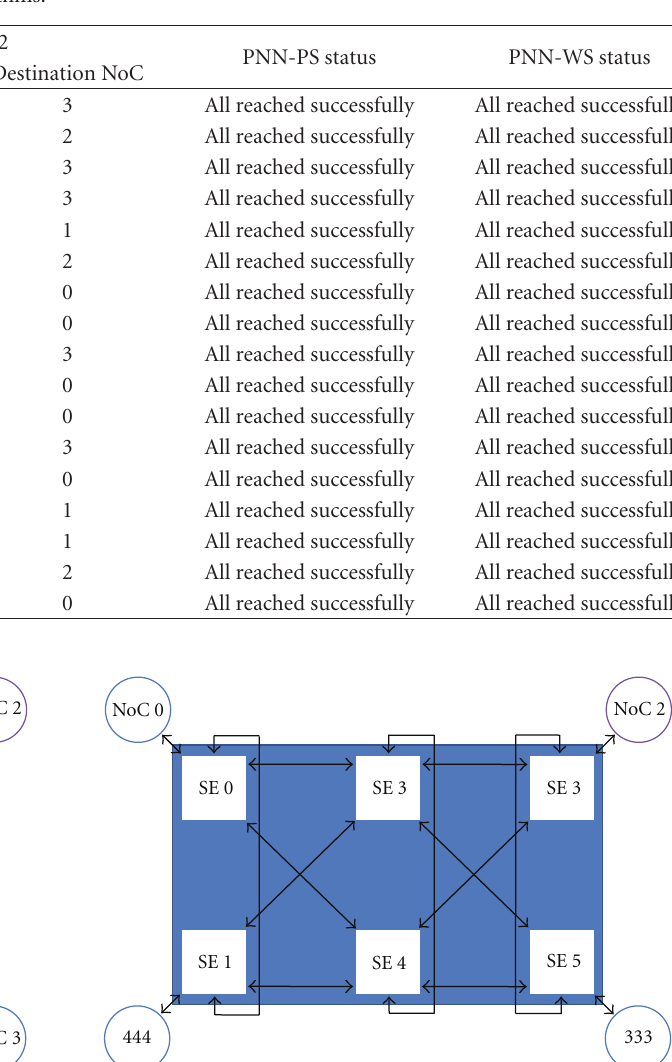
Table 12: The following source destination pairs of NoCs are used to show 100% e ffi ciency of the NiP (based on PNN, used as IoC). All source destination pairs delivered the payload information to the respective NoC. The following data does reflect the parallel communication among the NoCs using packet and wormhole switching algorithms.